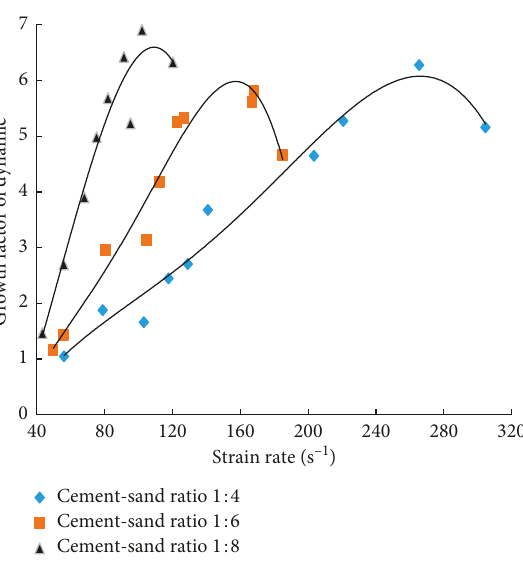
Figure 6: The stress and strain rate curve.